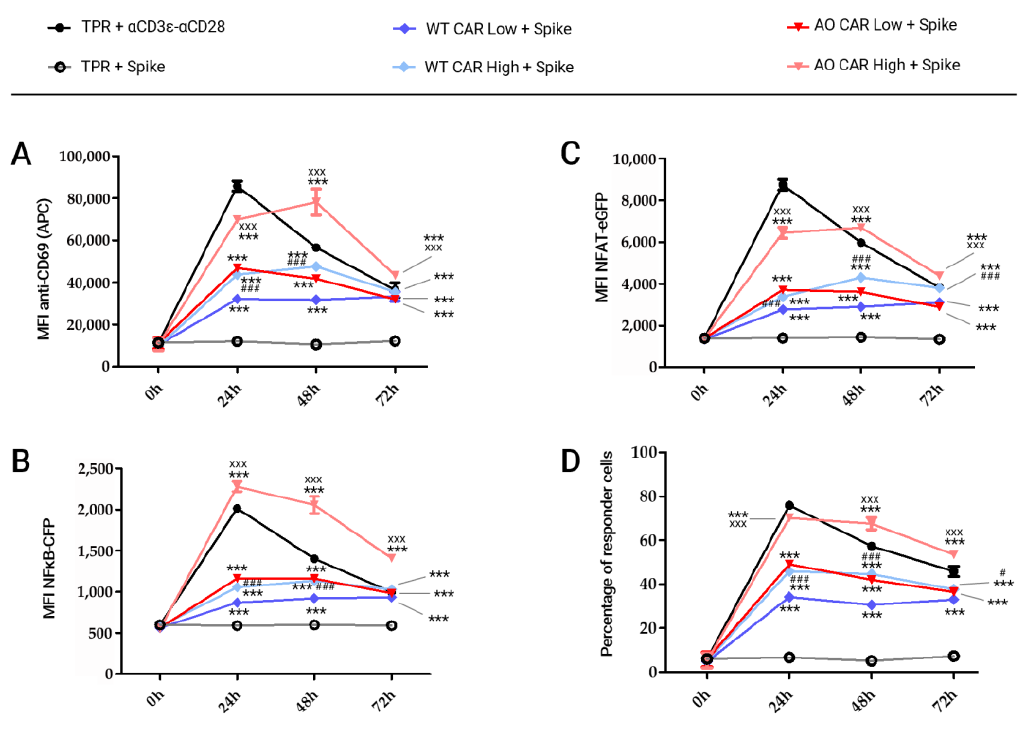
Figure 4. Kinetics of the activation of ACE2-CAR-TPR cells upon stimulation with Spike- or anti- CD3+anti-CD28 MACSiBead-coated particles. MFI values for CD69 upregulation ( A ) as well as NF κ B ( B ) or NFAT promoter activation ( C ) upon either Spike trimers or CD3+CD28 stimulation. Percentage of the cell that responded to at least one of the analyzed activation markers: NFAT, NF κ B and/or CD69 ( D ). Each symbol represents mean ± SEM of MFI values of three independent experiments performed in triplicate. Statistical analysis is indicated for each condition vs. non-stimulated cells (*** p < 0.001), Spike-stimulated WT-CAR High vs. WT-CAR Low ( # p < 0.05, ### p < 0.001) and Spike- stimulated AO-CAR High vs. AO-CAR Low ( xxx p < 0.001).